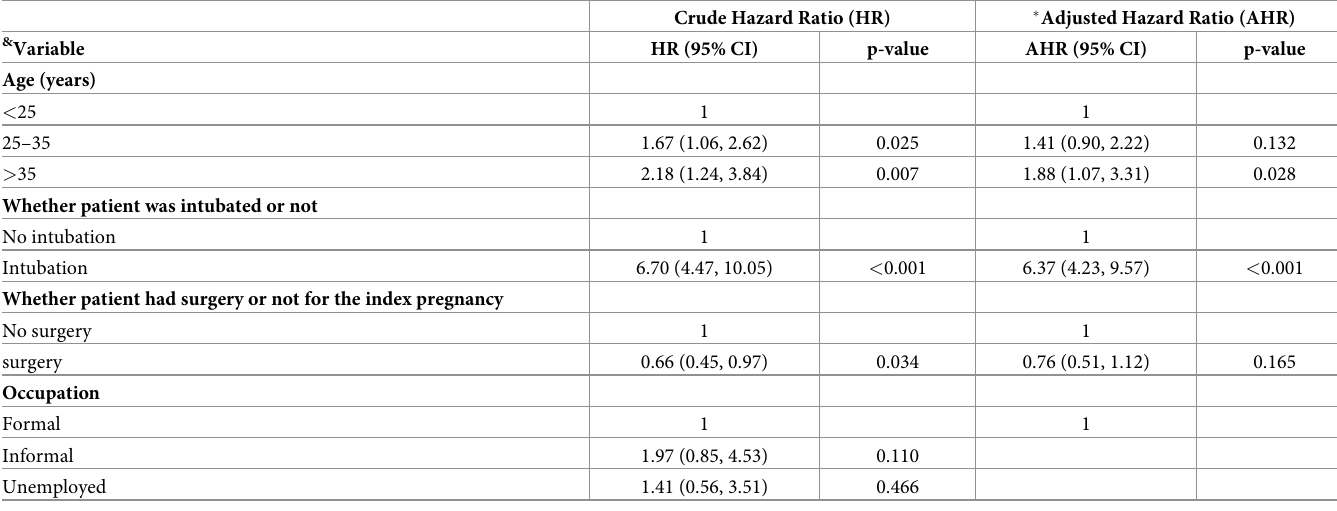
Table 2. Factors influencing obstetric ICU admission outcomes in Cape Coast Teaching Hospital from 2010 to 2019.